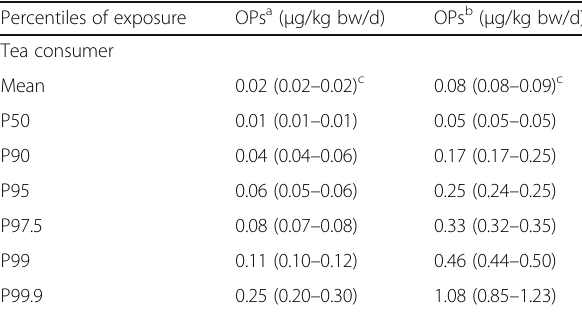
Table 5 Percentiles of distribution for dietary intake of Ops residues from tea infusion for tea consumers only in China Percentiles of